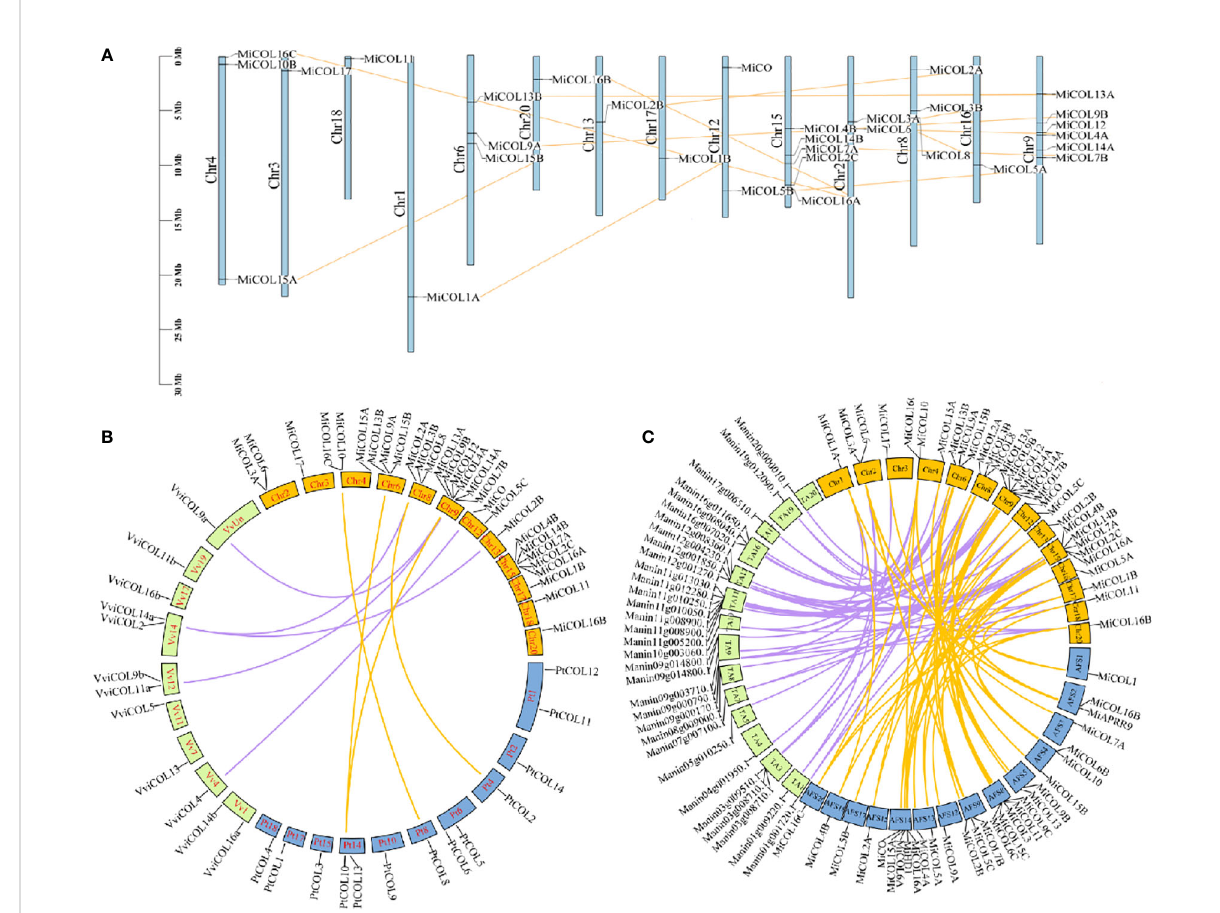
FIGURE 4 Chromosomal localization and synteny of MiCOL s. (A) The chromosome numbers are indicated at the top of each scaffold. The chromosome size is shown by the vertical scale. (B) Syntenic relationships of mango, Vitis vinifera and Populus trichocarpa COL genes. The colored lines represent the syntenic regions between mango and Vitis vinifera (purple) and between mango and Populus trichocarpa (yellow). (C) Syntenic relationships of MiCOL genes in different mango varieties. The colored lines represent the syntenic regions between ‘ JinHuang ’ and ‘ Tommy Atkins ’ (purple) and between ‘ JinHuang ’ and ‘ Alfonso ’ (yellow). The graph was generated via